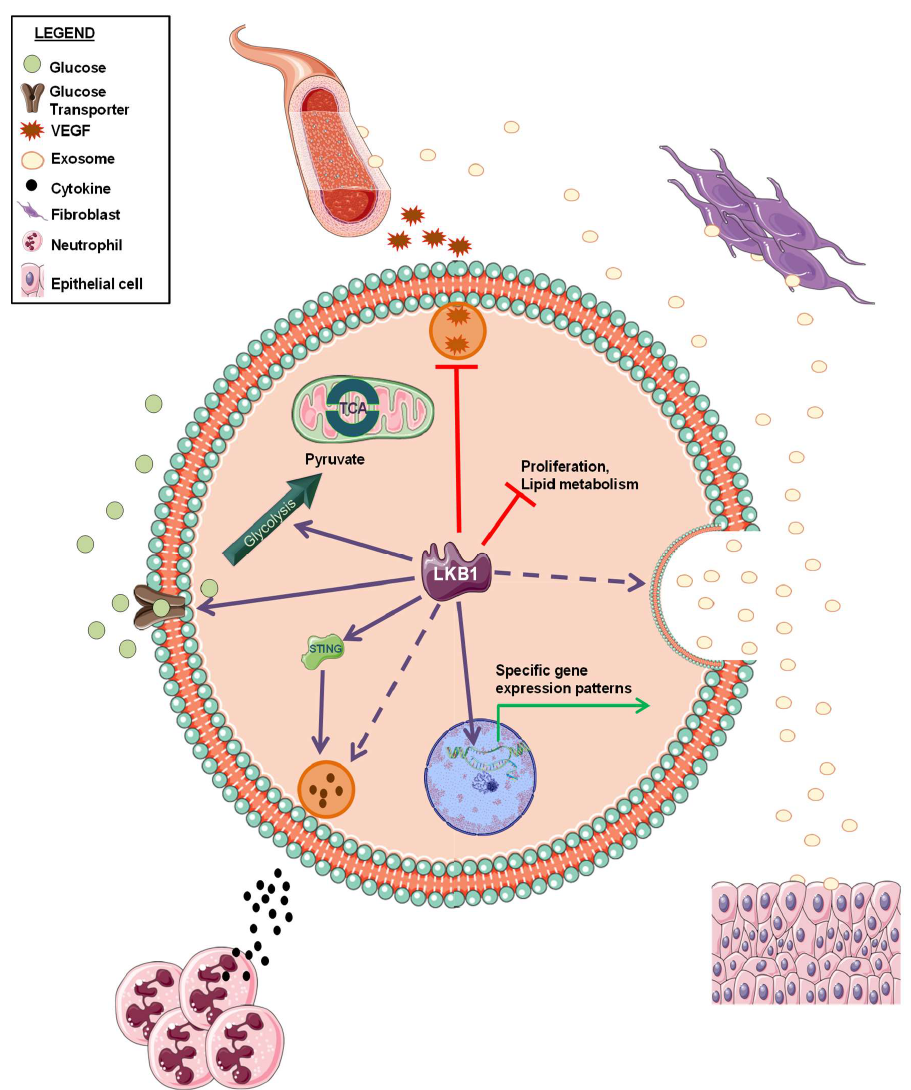
Figure 2. Schematic representation of LKB1 biological functions within tumor cells and in the interactions with tumor microenvironment. Solid and dashed arrows indicate a positive regulation by LKB1 (already published or not, respectively). Red “T” arrows indicate a negative regulation by LKB1